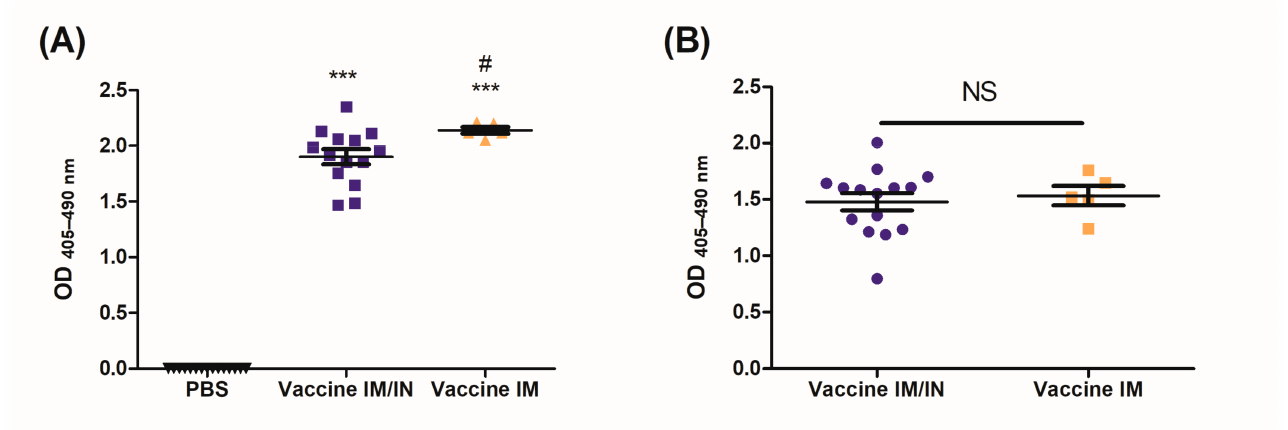
Figure 2. Levels of anti-nicotine IgG in the sera after the final vaccination. Mice were vaccinated on days 0, 21 and 42 using a control (PBS delivered IM/IN or IM), or the vaccine either delivered heterologously (IM/IN) or IM. Sera was collected on ( A ) day 56 or ( B ) more than 6 months (day 230) after the final vaccination, and analyzed using an indirect ELISA for total anti-nicotine IgG antibodies. For both ( A , B ), sera was diluted at 1:9600, n = 5–15 and data are represented as ± SEM. Statistical significance was determined by an ANOVA with a Tukey HSD, # p ≤ 0.05 as compared to Vaccine IM/IN, *** p ≤ 0.001 as compared to the PBS control. NS = not significant.